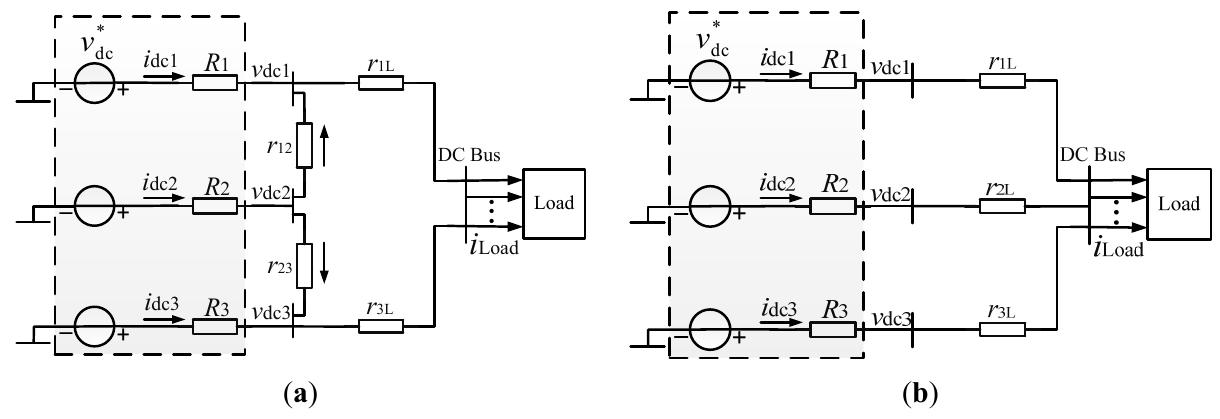
Figure 1. Distributed generation (DG) sources parallel operation diagrams. ( a ) Mesh configuration. ( b ) Radial configuration.